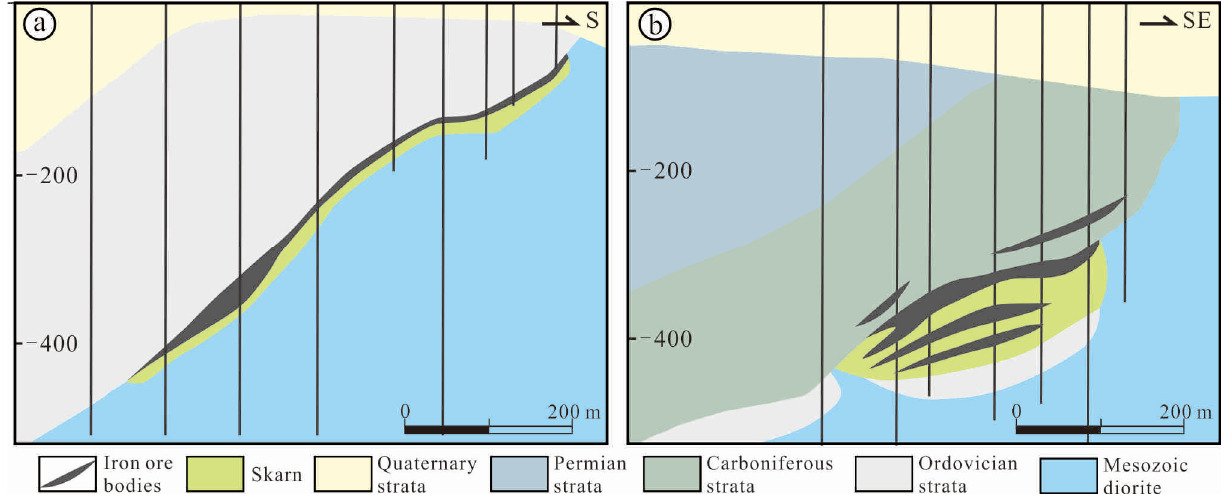
Figure 3. Cross-section diagram of the Jinling iron deposit (modified from Hao [23]). ( a ) Houjiazhuang ore section. ( b ) Wangwangzhuang ore section.